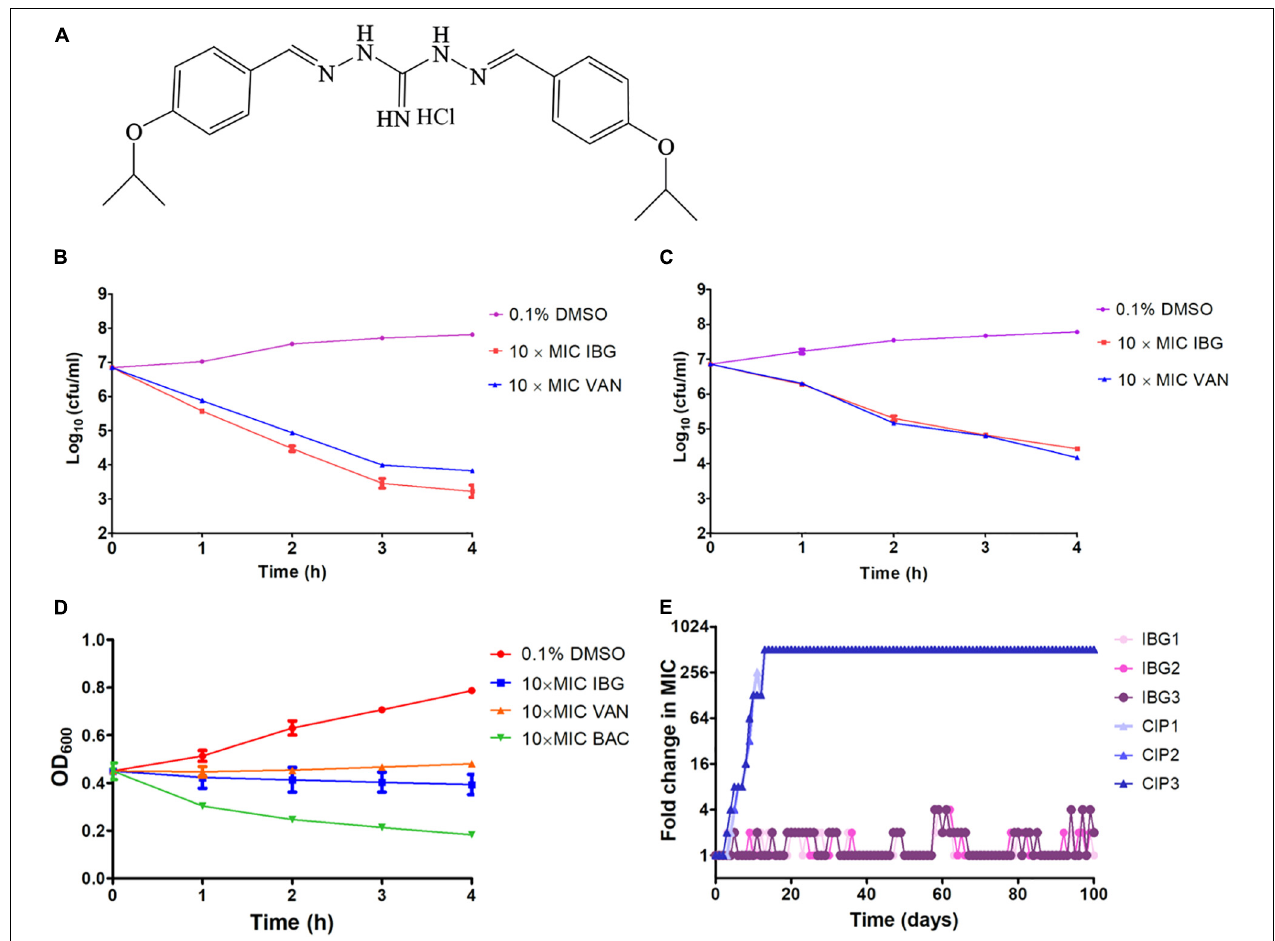
FIGURE 1 | IBG inhibits S. aureus growth without detectable mutant development. (A) Structure of IBG. (B) Viability of S. aureus ATCC 29213 treated with IBG or VAN. (C) Viability of MRSA ATCC 43300 treated with IBG or VAN for 4 h. (D) IBG treatment could not result in S. aureus ATCC 29213 lysis; (E) Appearance of spontaneous IBG and CIP-resistant S. aureus mutants over 100 days of serial passages. IBG, isopropoxy benzene guanidine; VAN, vancomycin; CIP, ciprofloxacin; Individual data points ( n = 3 biologically independent experiments) and mean ± SD. are